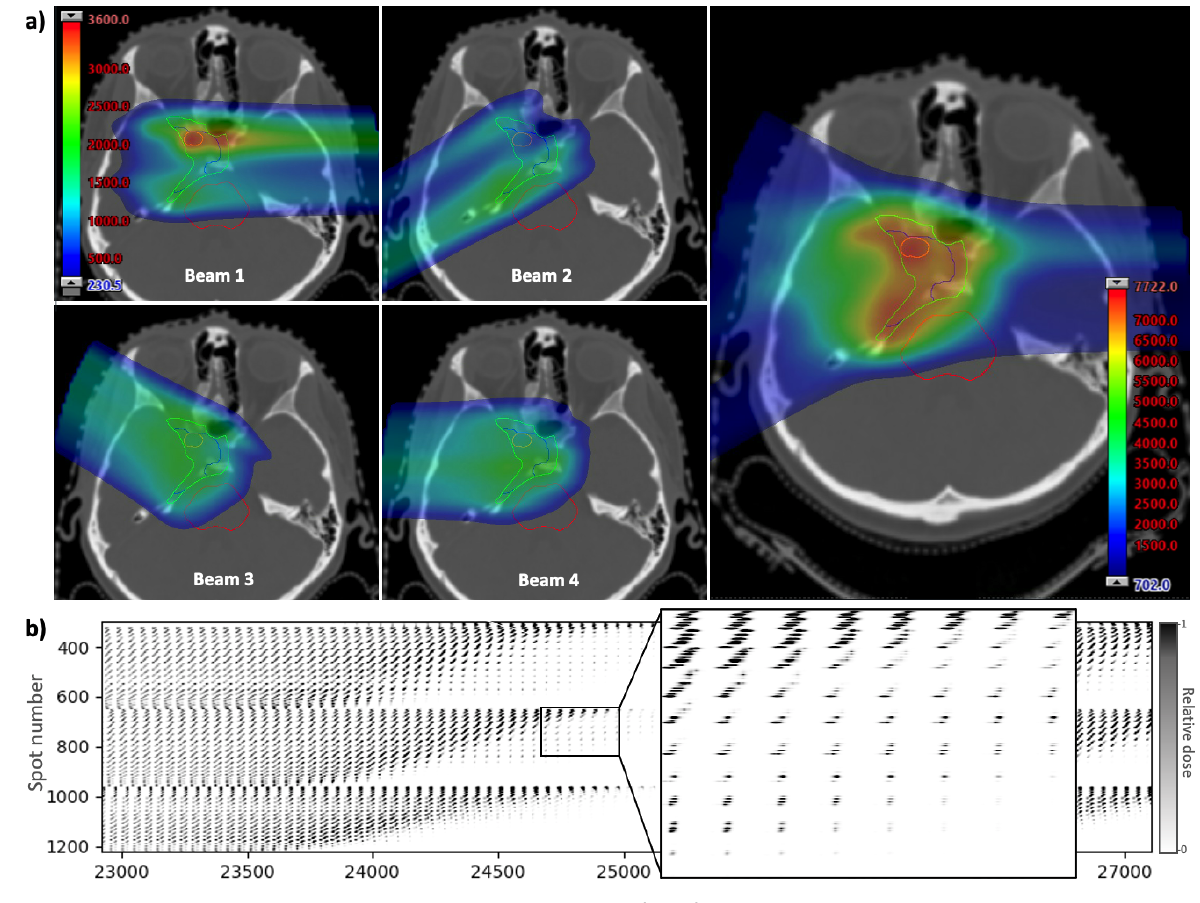
Figure 2. ( a ) A clinical base of skull treatment plan showing the contribution of dose from four beams (left) and the full dose map (right) overlayed onto a CT slice. Dose distributions are generated using Eclipse (Varian Medical Systems, Palo Alto, CA, USA). ( b ) Extract from the corresponding influence matrix showing the contribution of each spot to each voxel in the treatment volume. Each voxel in the three-dimensional treatment plan is reshaped into a one-dimensional list by assigning a number (in order of increasing z , then by increasing x , then by increasing y ) to form the columns of the influence matrix. The list of spots, in the order they are delivered, make up the